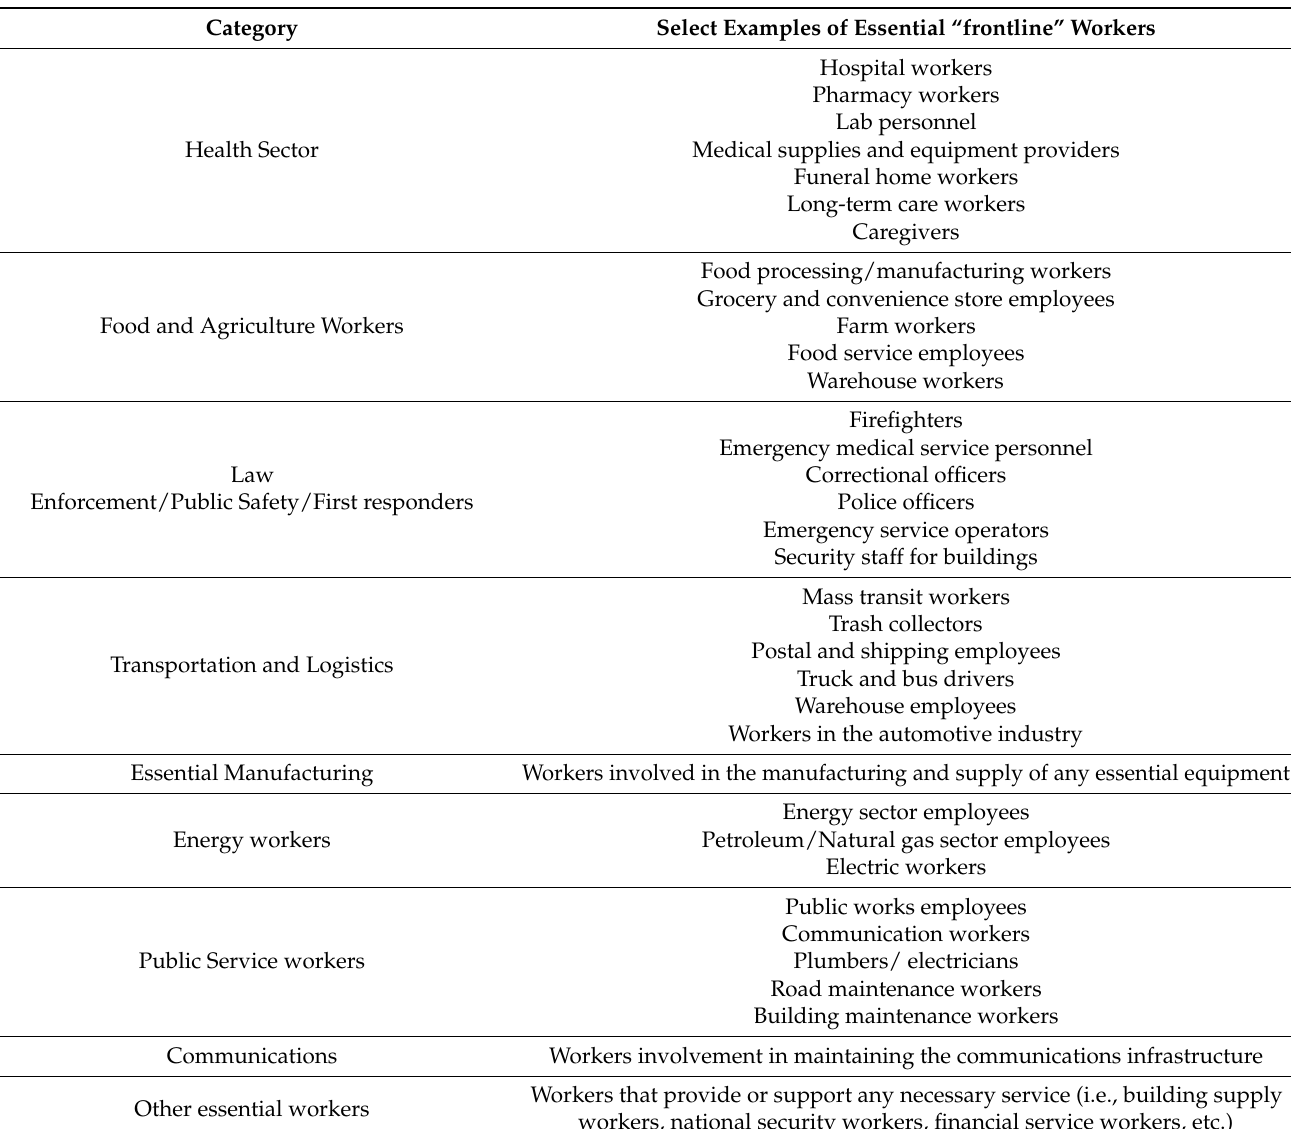
Table 1. Essential Worker Occupations